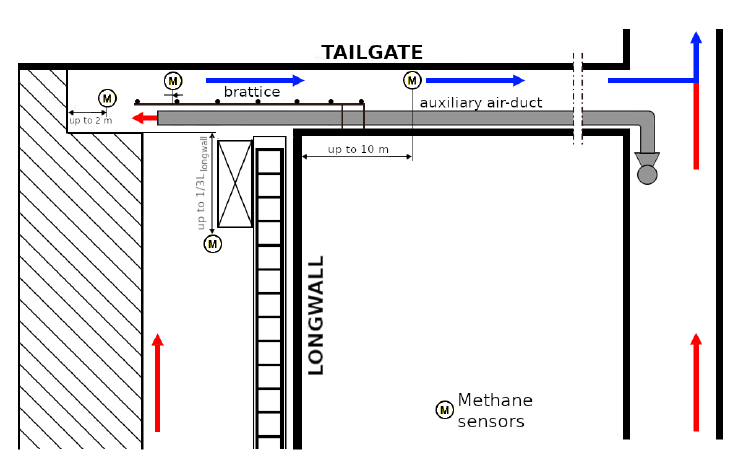
Figure 1. The longwall and tailgate crossing with a built-in brattice and auxiliary air-duct (own